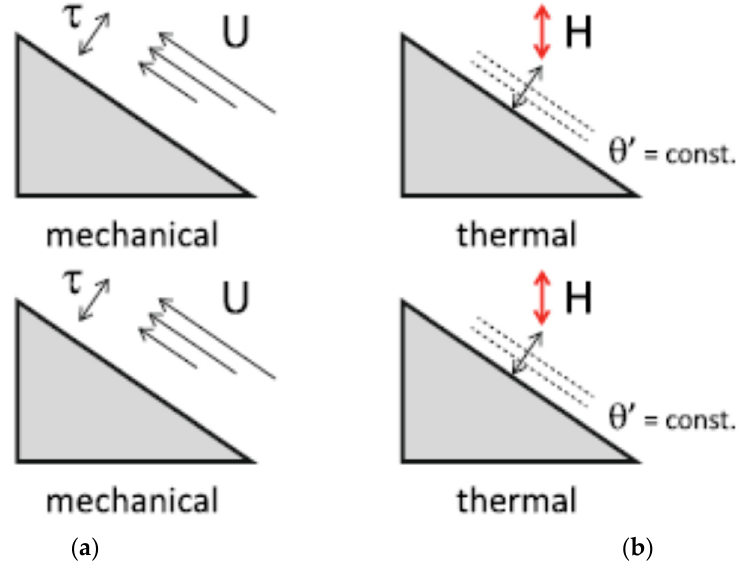
Figure 3. Definition of local coordinates over (ideally) sloped terrain, in ( a ) for mechanical (left) and ( b ) thermal (right) properties. In ( a ) τ corresponds to the longitudinal component of shear stress (frictional stress), U is the longitudinal wind component, in ( b ) θ′ -lines denote isolines of potential temperature perturbations (around a mean state) and H is the sensible heat flux (from [85], Copyright: Open Access, CC-BY).